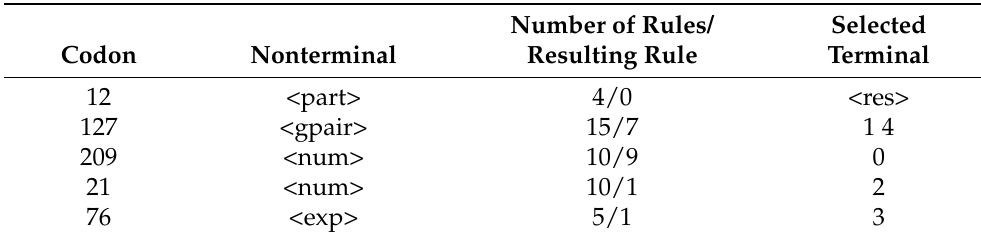
Table 3. Using the chromosome { 12,127,209,21,76 } to map the start symbol <part> to an actual circuit